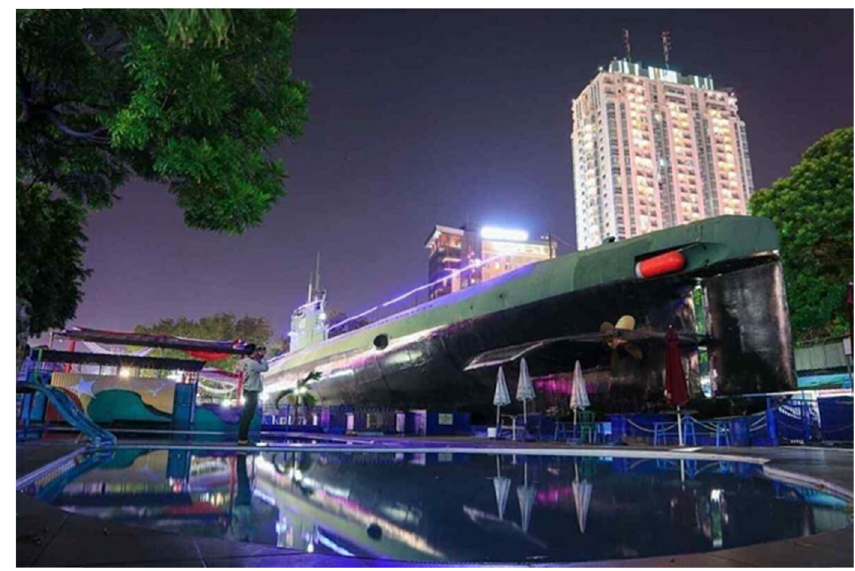
Figure 2: The neighbouring landscape of Monumen Kapal Selam in